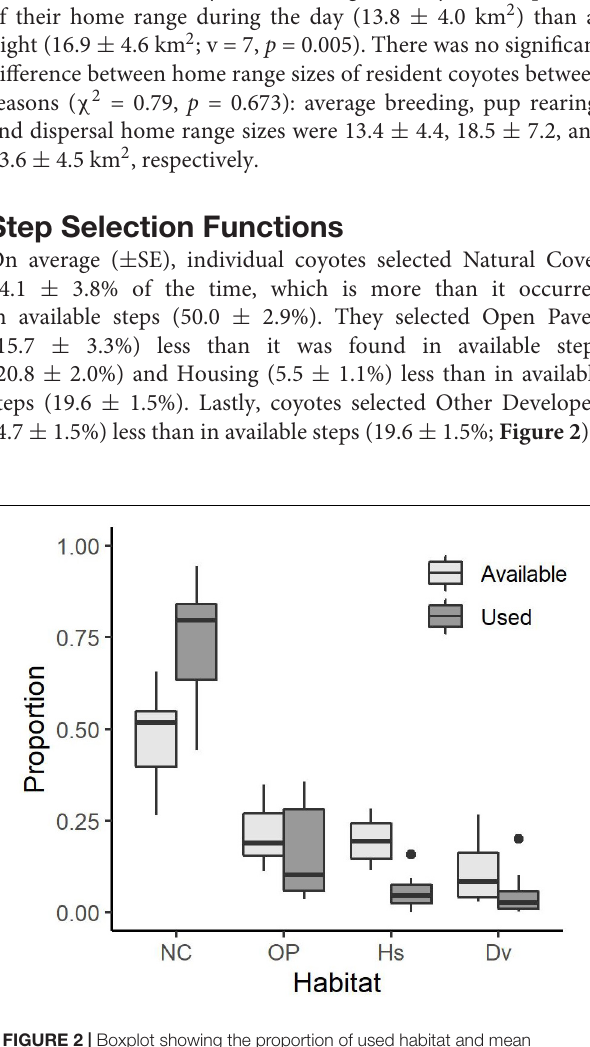
Frontiers in Ecology and Evolution |